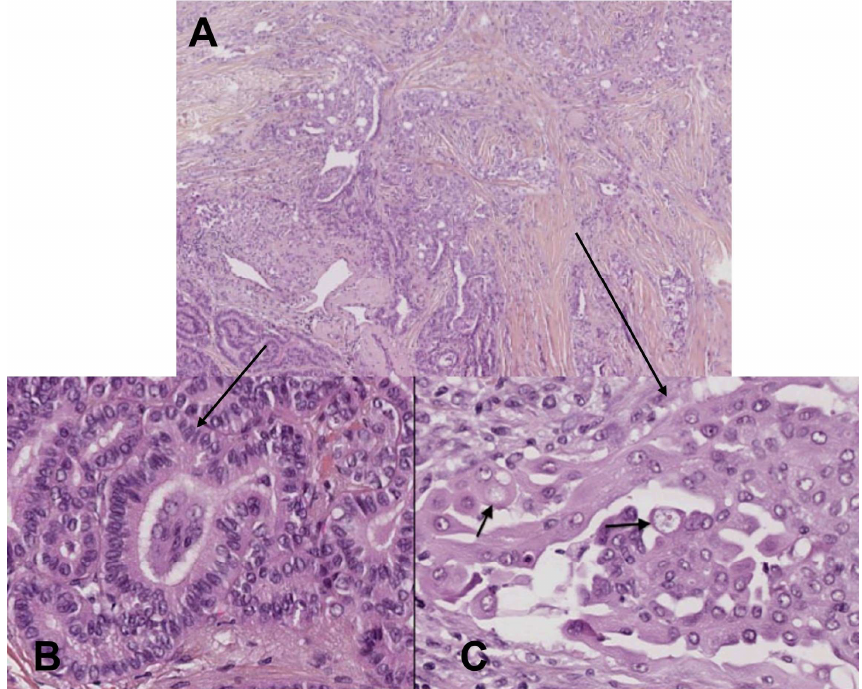
Figure 4. Composite MEC and columnar cell variant of papillary carcinoma. ( A ) Variable architecture: papillary, follicular, solid, and cribriform areas intermingled ( × 100 magnification). ( B ) Component of columnar cell variant of papillary carcinoma: papillary and follicular areas, columnar stratified neoplastic cells with an abundant cytoplasm and a hyperchromatic nucleus ( × 400 magnification). ( C ) Component of MEC: cribriform area, large round to polygonal tumor cells with abundant eosinophilic cytoplasm intimately admixed with few tumor cells containing clear intracytoplasmic vacuoles of mucin (arrows) (×400 magnification).